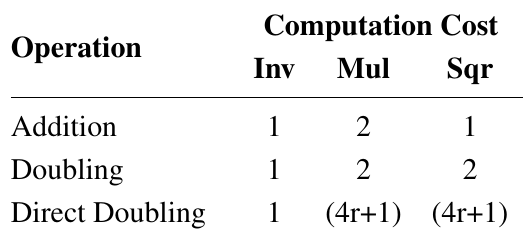
Table 8. Required number of finite field operations. Inv: inversion; Mul: multiplication;